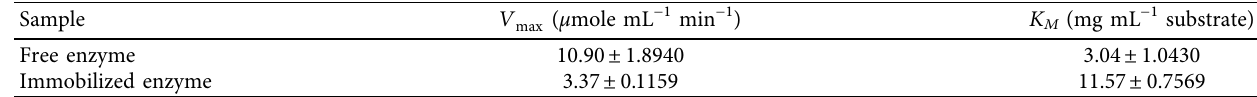
Figure 5: Lineweaver–Burk plot analysis of the enzymatic kinetics of free and immobilized enzyme. The data are presented as mean ± SD; n � 2; p ≤ 0 . 05. The error bars represent standard deviations from two replicates Table 1: K V values for free and immobilized enzymes. M and max